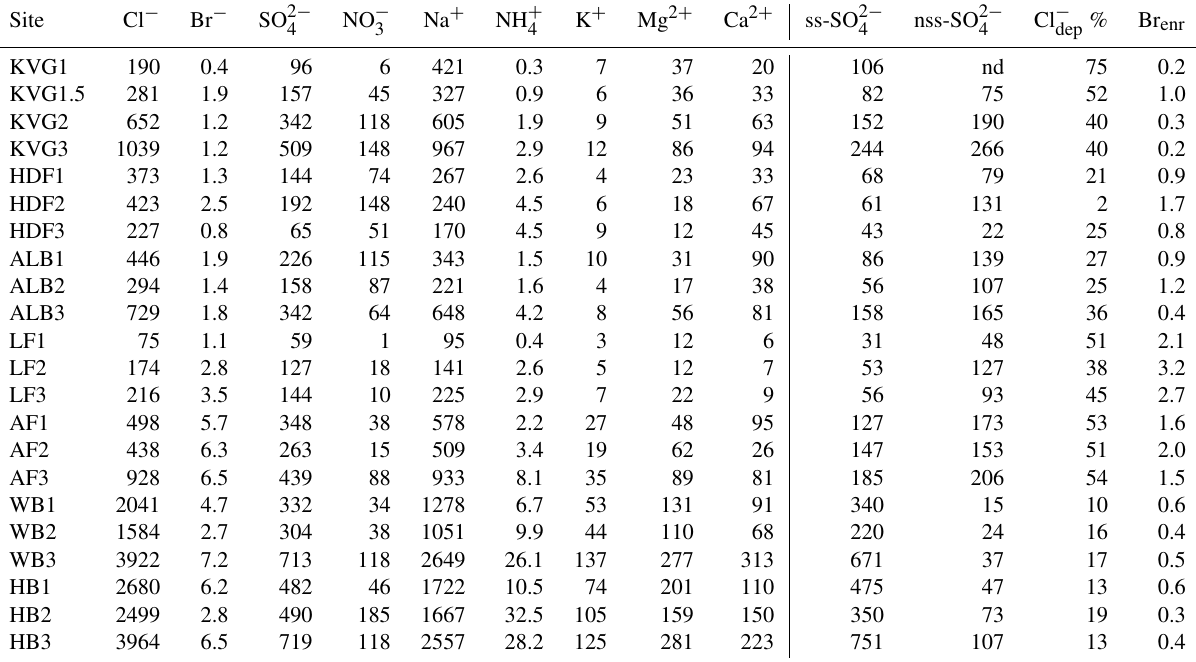
Table 2. Total load (mgm − 2 ) of major ions, calculated as the sum of loads in all layers of each snowpit. Sea-salt sulfate (ss-SO 2 − non-sea-salt sulfate (nss-SO 2 − ) are expressed as mgm − 2 , while chloride depletion (Cl − 4 (Br enr ) refers to an enrichment compared to seawater